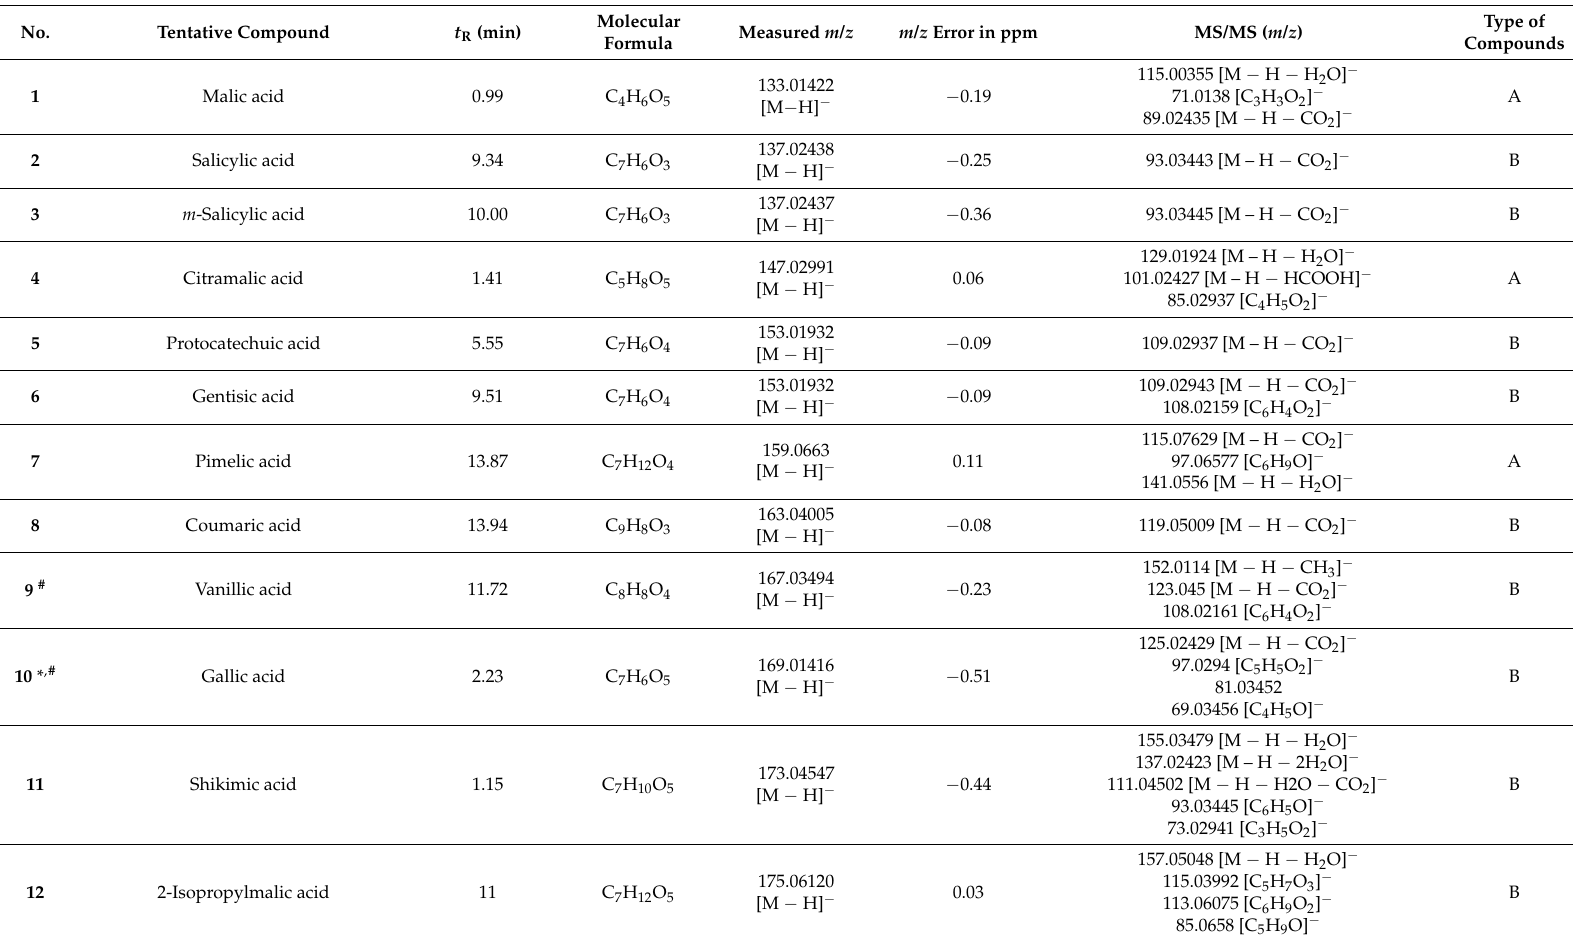
Table 1. Tentative identification of the chemical constituents of Melastoma dodecandrum Lour. by UPLC-ESI-Q-Exactive Focus-MS/MS in negative and positive modes.